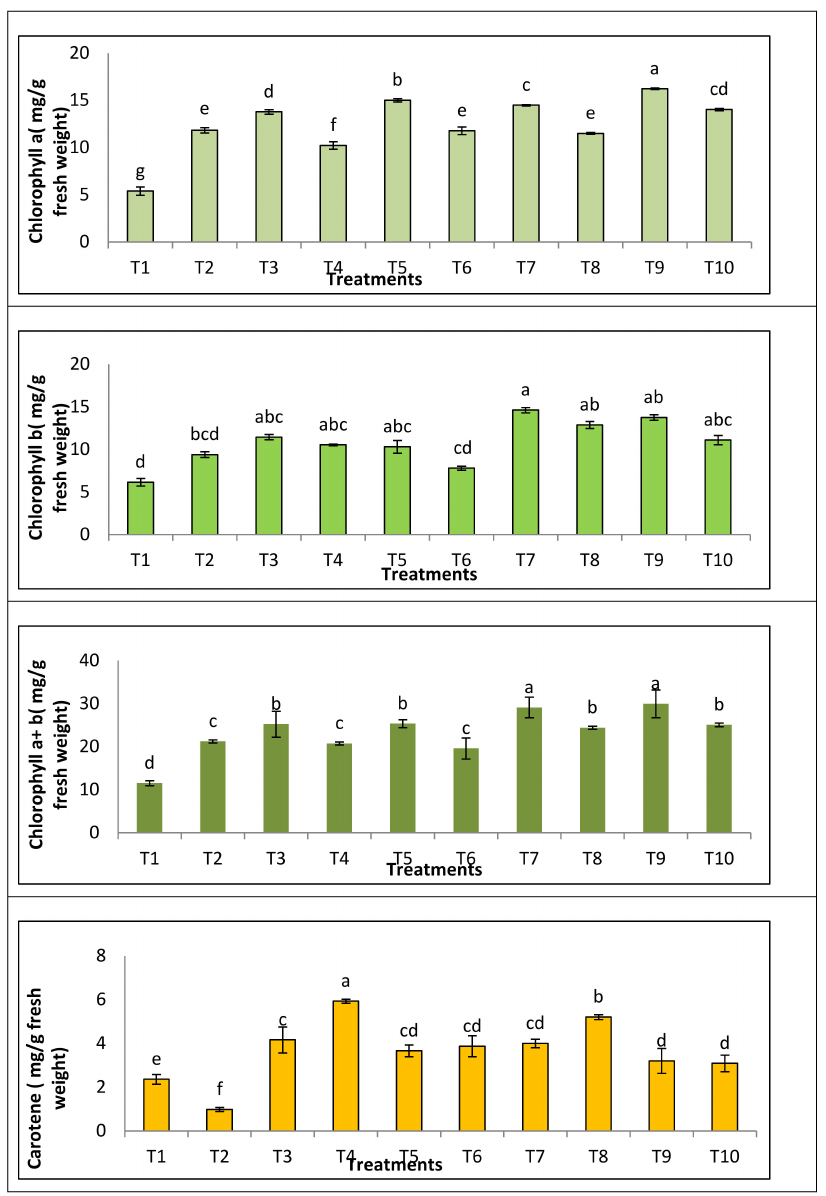
Figure 5. Photosynthetic pigments of tomato plant treated with PGPF. (T1) infected control, (T2) healthy control, (T3) healthy + M. circinelloides , (T4) infected + M. circinelloides , (T5) healthy + P. oxalicum , (T6) infected + P. oxalicum , (T7) healthy + A. niger , (T8) infected + A. niger , (T9) healthy + A. flavus , (T10) infected + A. flavus